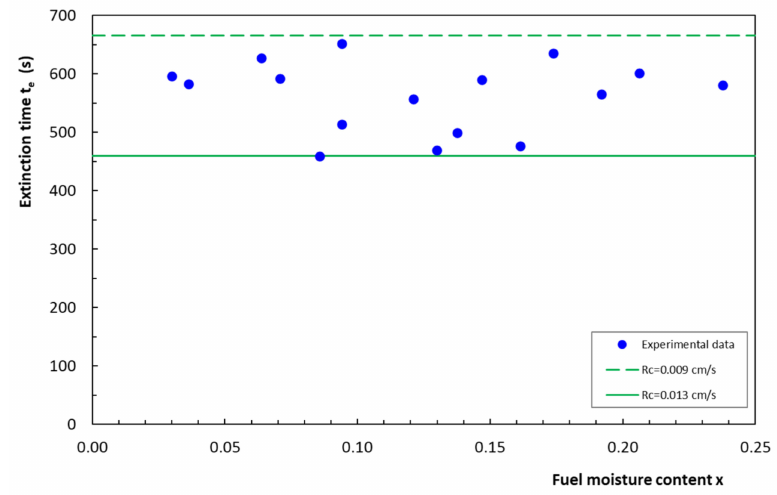
Figure 9. Values of extinction time t e of cigarettes with constant moisture value x T as a function of fuel moisture content x (Series CS5). The horizontal lines correspond to burnout times of cigarettes with R c values that are indicated in the legend.